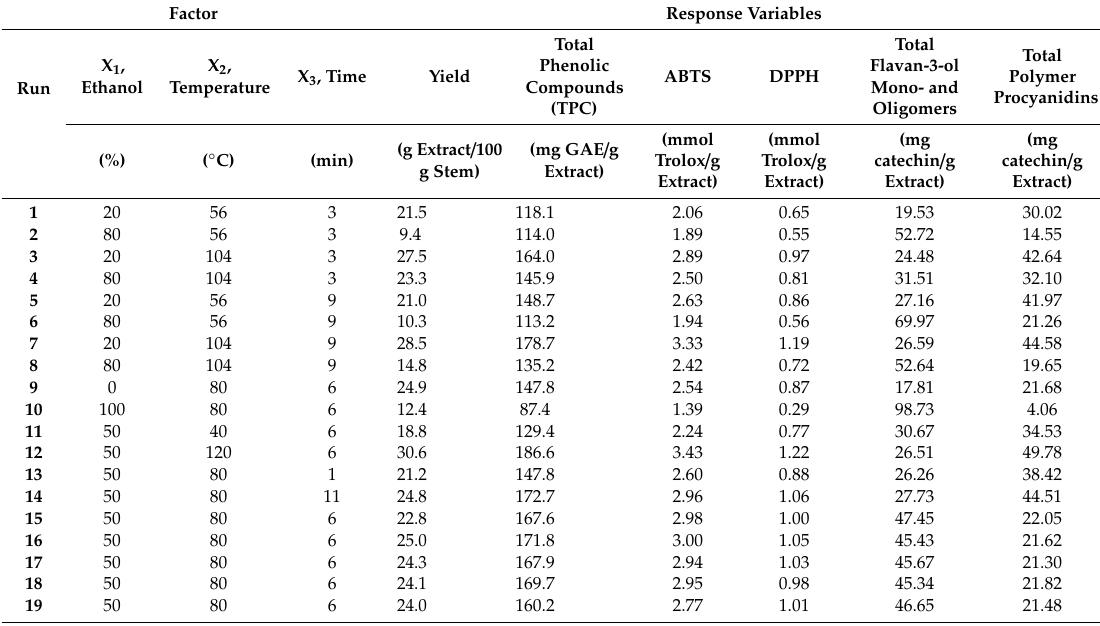
Table 2. Experimental design and experimental response variable